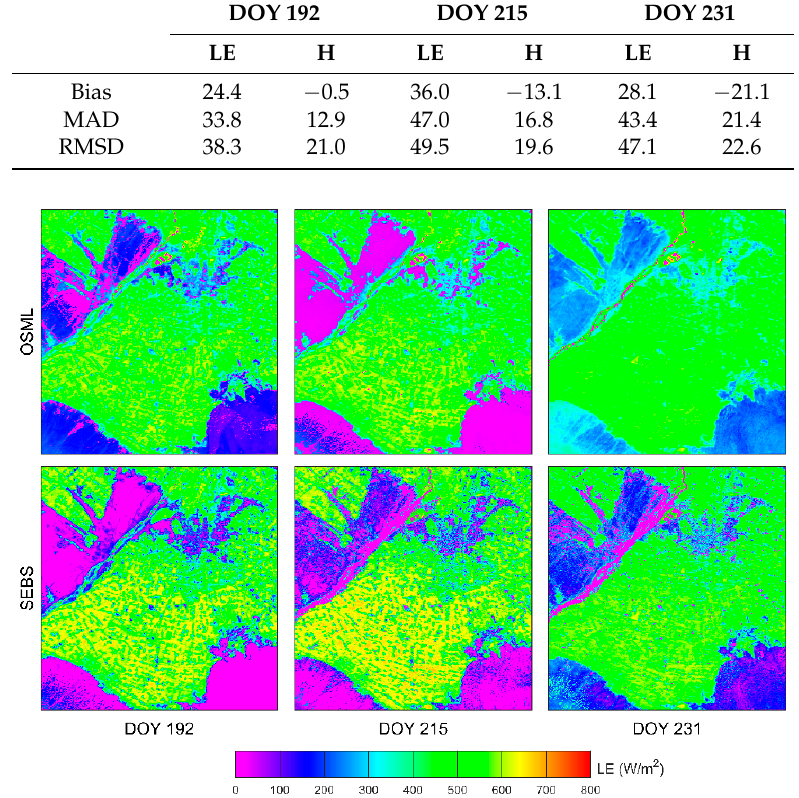
Figure 12. The spatial distribution of LE over MUSOEXE site based on OSML and SEBS from satellite-based variables at satellite overpass time on DOY 192, DOY 215 and DOY 231 of 2012.